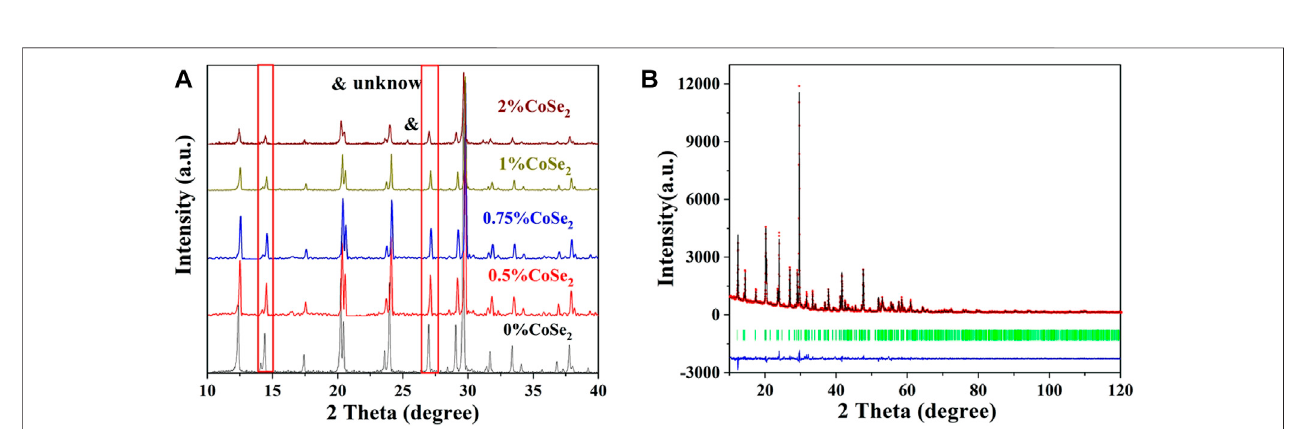
FIGURE 7 | XRD pattern of the CoSe 2 doping Li 10.35 Si 1.35 P 1.65 S 12 (A) and the Rietveld re fi nement of 1% CoSe 2 -doped sample (B) .